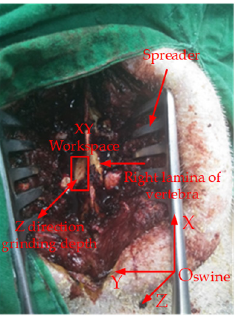
Figure 3. Swine spinal laminectomy surgery.